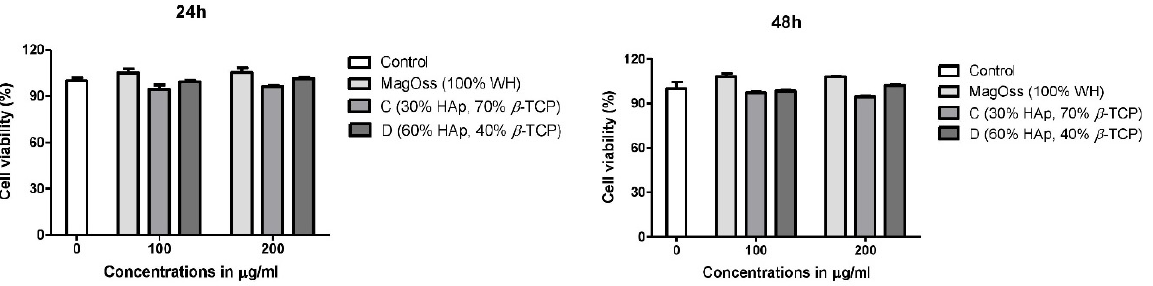
Figure 6. Effect of bone grafts on cell viability of human adipose-derived stem cells.